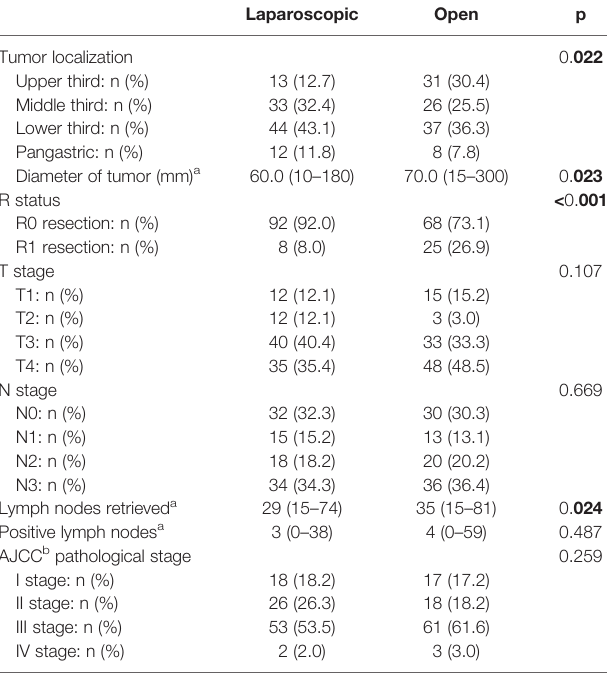
a Data shown represent median (range). b American Joint Committee on Cancer, 8th edition. In bold: statistically signi fi